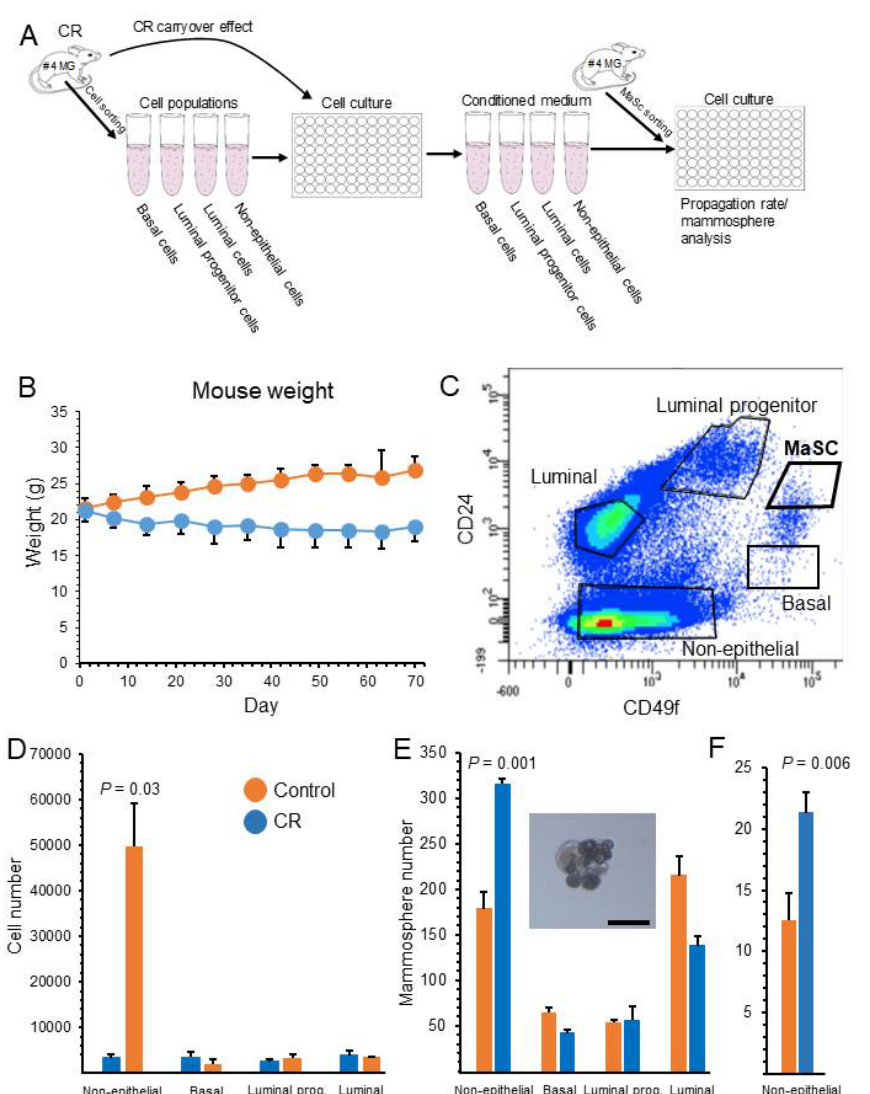
Figure 1. Initial recognition of the non-epithelial cell population as a mediator of the inductive effect of calorie restriction (CR) on mammary epithelial stem cell (MaSC) self-renewal. ( A ) Scheme of the experiment. Four candidate mammary cell populations from ad libitum-fed and CR mice were sorted and cultured for 4 days: basal, luminal, luminal progenitors and non-epithelial. Conditioned medium was collected and incubated with freshly isolated MASCs for 8 days. Cell propagation and mammosphere formation were monitored at later dates. ( B ) A 30% difference in body weight was observed between CR mice and their ad libitum-fed counterparts at the end of the in vivo experi- mental period. Dots represent mean ± SEM of 20 mice’s body weight. ( C ) Flow cytometry analysis of Lin - mammary cells identified five cell populations. The MaSC population is emphasized. ( D ) Conditioned medium from CR non-epithelial cells induced cell propagation in cultures initiated by MaSCs. Conditioned medium was collected from 12,000 cells/well of each population incubated for 4 days in 100 µ L mam- mary medium in 96-well plates. It was then added to freshly prepared MaSC cultures (100 µ L to 500 cells/well). After 12 days of incubation, the cells were counted. Only conditioned medium from CR non-epithelial cells increased cell-propagation rate, compared to its respective control. Bars represent mean ± SEM of 5 replications. ( E , F ) Mammosphere formation was induced after 41 days of incubation (E > 4 cells, F > 10 cells) by conditioned medium of CR non-epithelial cells. See Panel D for the number of seeded cells. Inset: typical mammosphere. Representative demonstration of three independent experiments, starting from the in vivo CR period, is presented. Bars represent mean ± of 5 replications. Bar = 50 µ m. MG—mammary